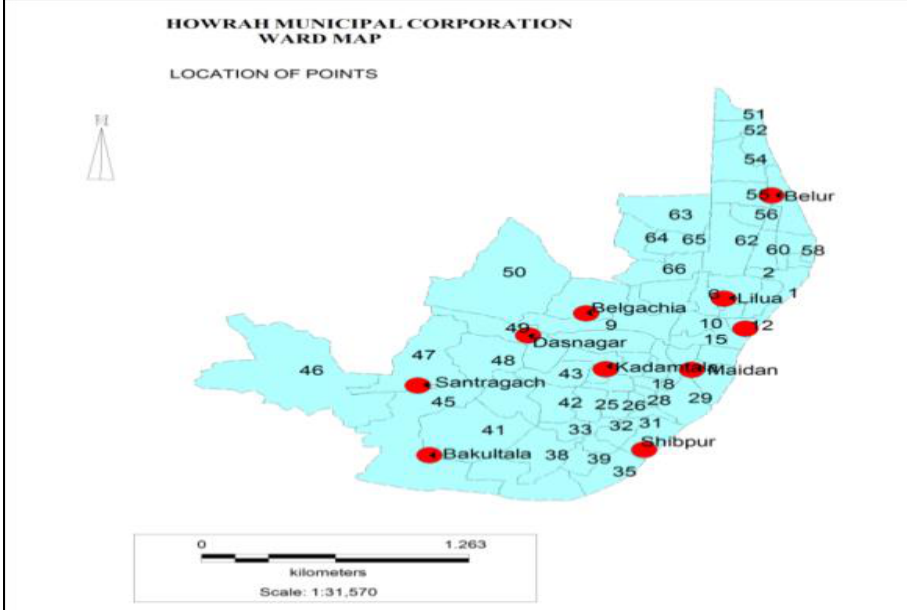
Figure 8. Location of points in HMC.